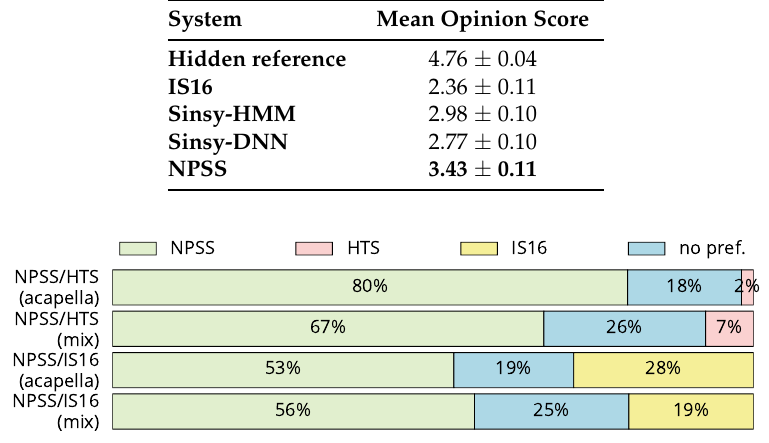
Figure 7. Results of the preference test for systems trained on pseudo singing. The Sinsy-HMM and Sinsy-DNN systems were excluded from this comparison, as the only available models are trained on natural